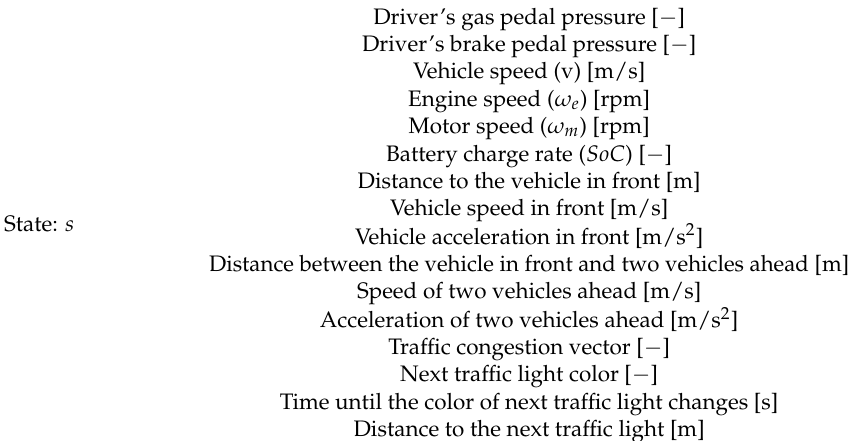
Table 1. Each element of state vector s